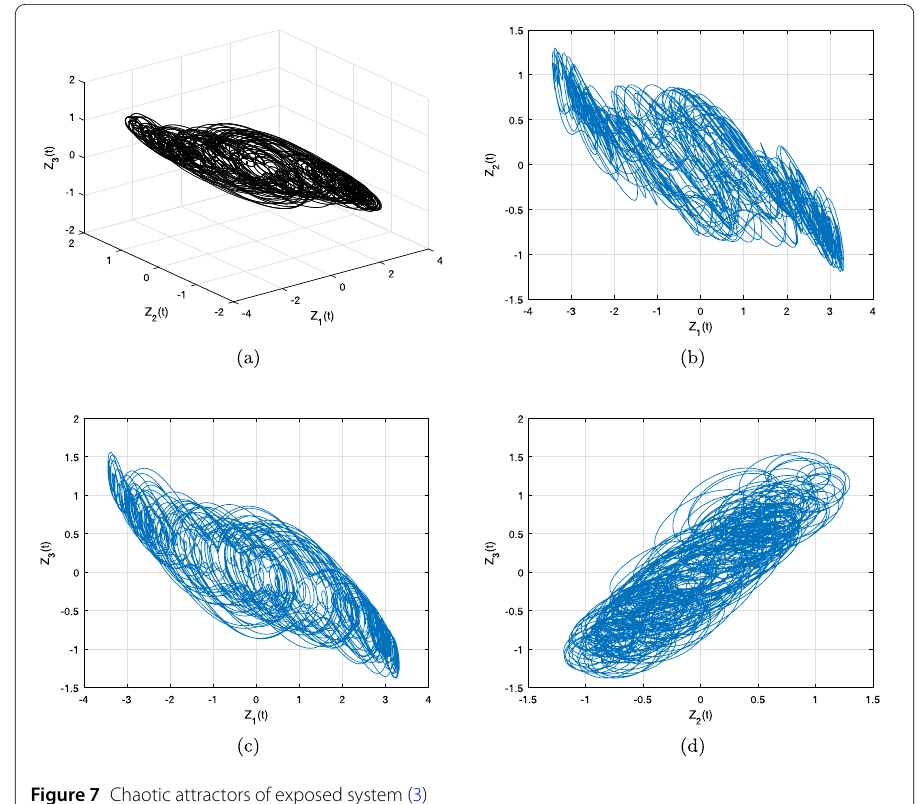
Figure 7 Chaotic attractors of exposed system